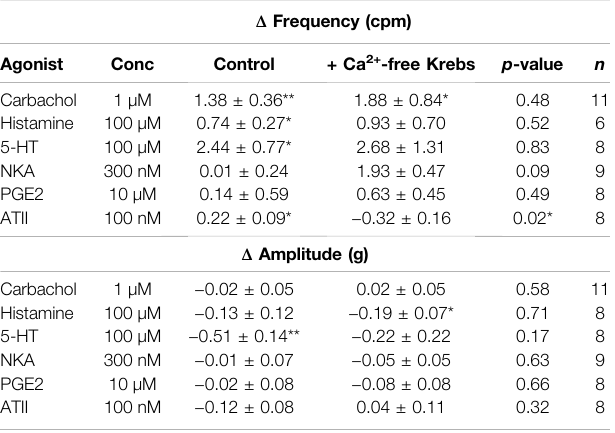
TABLE 3 | U&LP change in frequency and amplitude responses to receptor agonists in the absence (control) and presence of nominally zero Ca 2+ solution. No signi fi cant differences between the average amplitude changes between the absence and presence of nominally zero Ca 2+ solution for any of the agonists. Data presented as mean ±